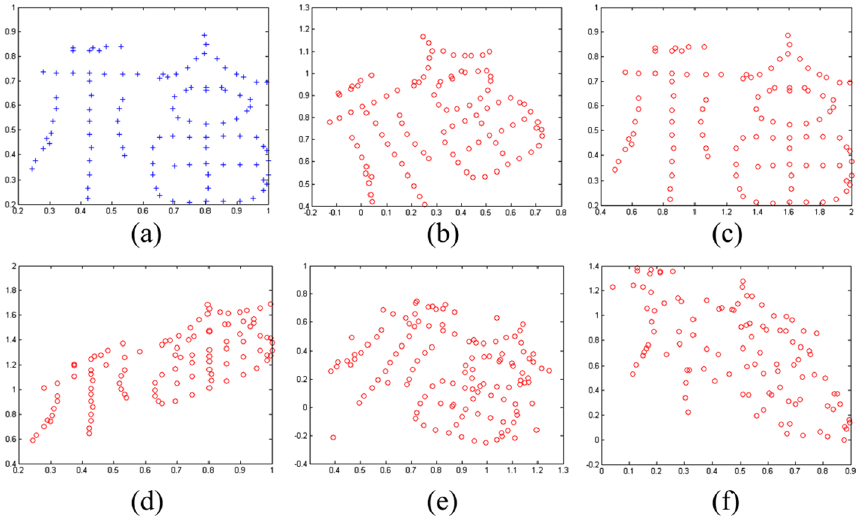
Fig. 3 Illustration of the effect of distortions, outliers and noise on a point set. a An original point set, and it is transformed by b rotation ( θ = 30 ◦ ), c non-uniform scaling ( sx / sy = 2 ), d shearing ( k = 1 ) or contaminated by e outliers (ODR 0.2) and f) noise (NSR = =